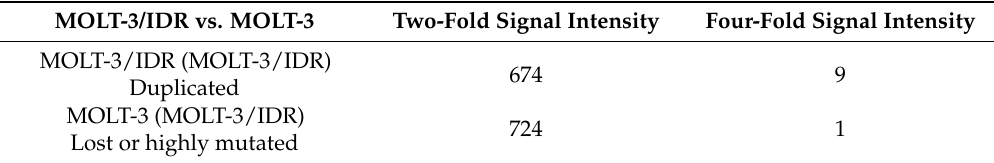
Table 2. Probes showing two- and four-fold increase in signal intensity on a CGH array comparison of MOLT-3/IDR versus MOLT-3